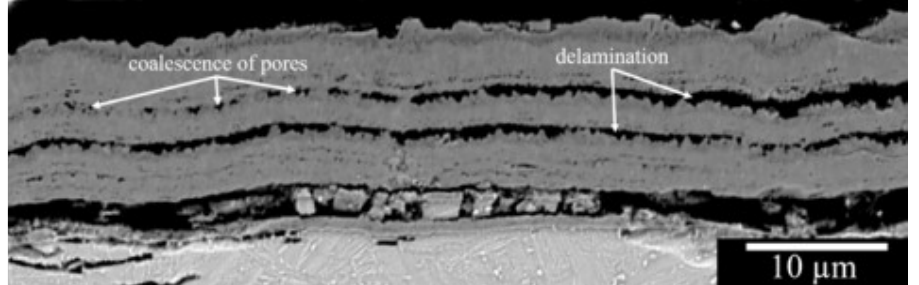
Figure 8. Delamination in WAAM, adapted from [21].